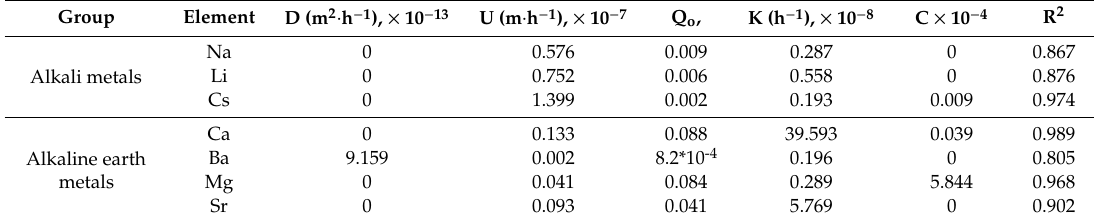
Table 13. Nonlinear curve fitting parameters of the cumulative leach fraction of alkali and alkaline earth metals: MABS-Waste (20).